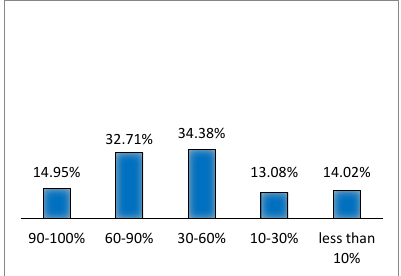
Figure 11. Approximately what proportion of the